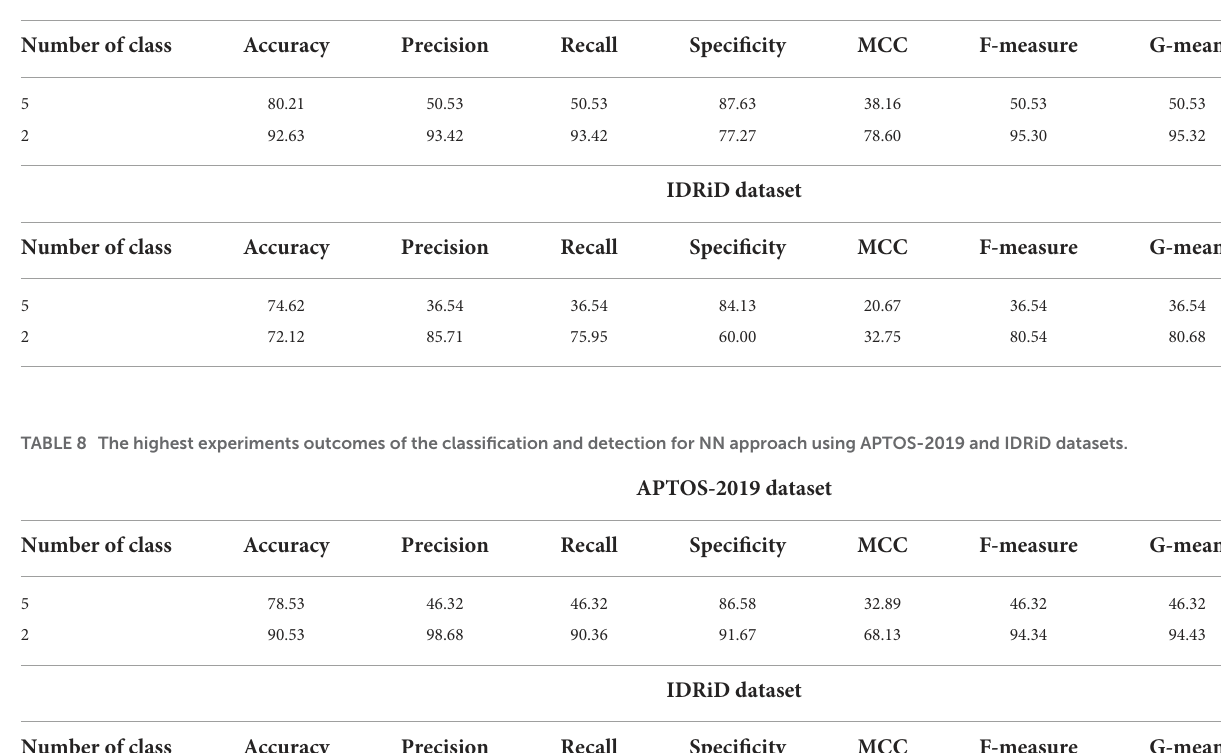
TABLE 7 The highest experiment outcomes of the binary and multi-class classifications for ELM approach using APTOS-2019 and IDRiD datasets.